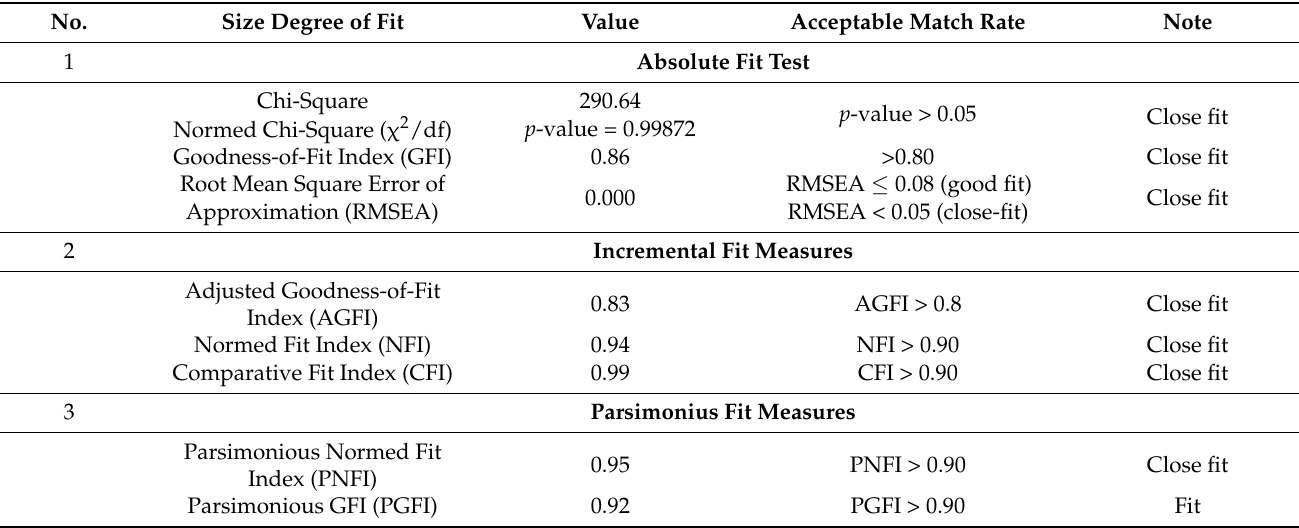
Table 3. Goodness-of-Fit Analysis, Source: Lisrel 8.7 output.